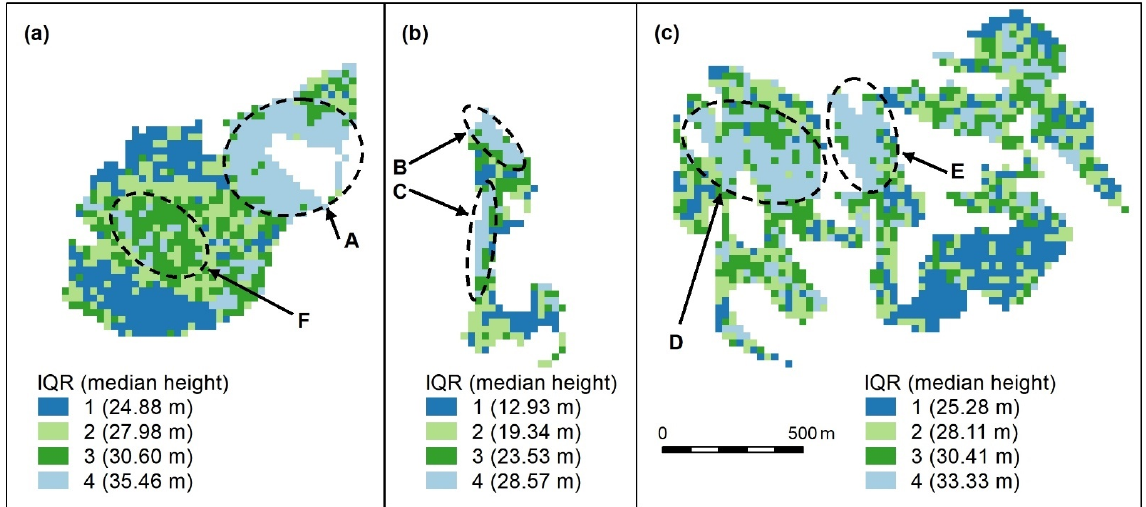
Figure 9. Polygon groups representing compact ( a ), linear ( b ), and complex ( c ) shapes, with interquartile ranges (IQR) and interquartile median height. We used these maps to assess clustering algorithms. Higher ‐ canopy spatial patterns are evident, for e.g., patches of higher canopy (A–E, light blue), and a canopy area of moderate height (F, dark green, some light green and light blue), surrounded by canopy with slightly lower height (light green). Heights appear more randomly distributed in other areas (light green, dark green) except for areas of lowest canopy height (dark blue). All maps use the same scale. Table 12. Visual evaluation by a panel composed of one author (DM), a GIS analyst (DS) and an ecologist (DJ); for maps produced for individual polygons by clustering algorithms. Maps were ranked according to how well six nominated fea ‐ tures (A–F in Figure 10) were captured by each algorithm, each with 2, 3, and 4 classes. Panellists first independently allocated scores, disagreements were highlighted, and the panellists re ‐ evaluated their scores. Key: P—feature identified (1), not identified (0); A—feature has similar area (1), smaller or larger (0); C—feature contiguous (1), not contiguous (0), ‘s’ prefix denotes spatially constrained algorithm. 1 1 1 = panellists agree that feature recognised by algorithm using all criteria ‐ 0 0 0 feature not recognised using any criteria ‐ Dark grey cells indicate panellists agree with individual criteria, 0/1 one panellist disagrees. For all cells, there was 86.3% agreement by all panellists. Panellists most often disagreed on whether feature D was captured. Nonspatial K ‐ medians (all classes) has the highest overall score, followed by nonspatial K ‐ means. For 4 classes, Redcap ranked slightly higher than nonspatial K ‐ medians. Feature